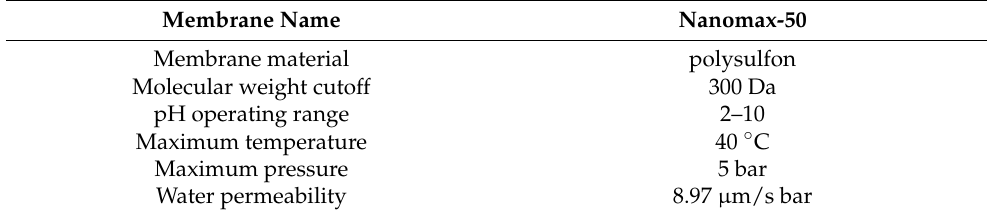
Figure 1. Schematic of the spiral wound polymeric membrane (Nanomax 50, Millipore USA) system with tangential filtration. Table 2. Characteristics of the membrane used in this